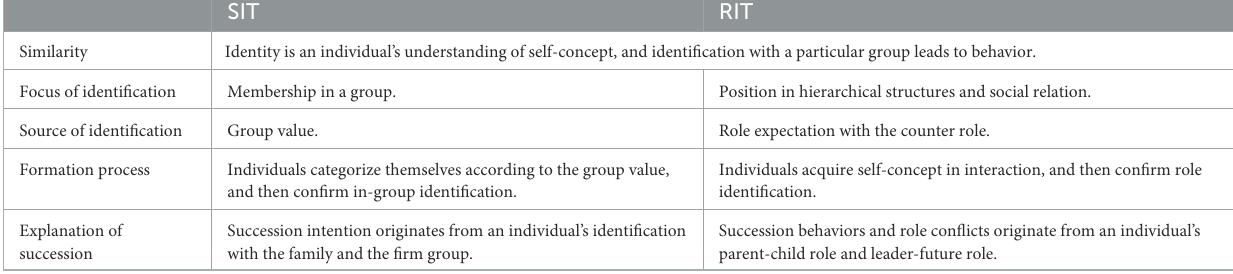
TABLE 1 Comparison between SIT and RIT. SIT